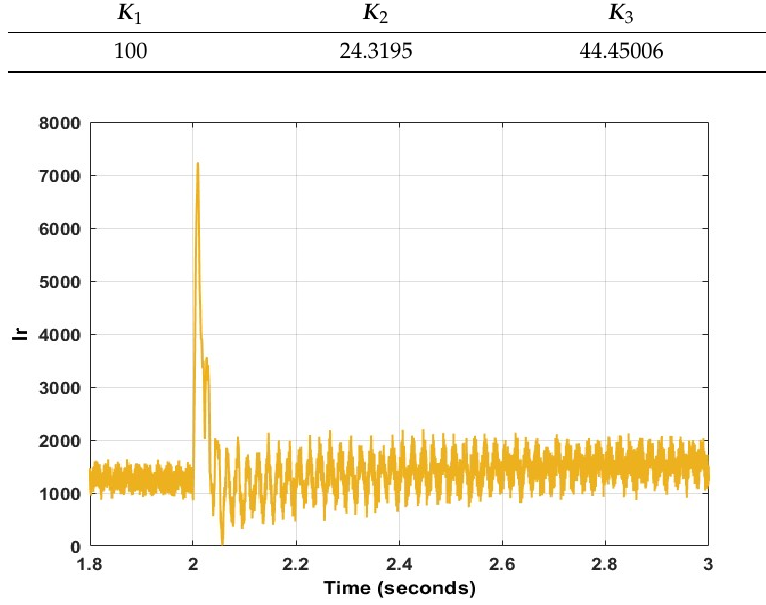
Figure 54. DC voltage transient using LQR at 90% dip.